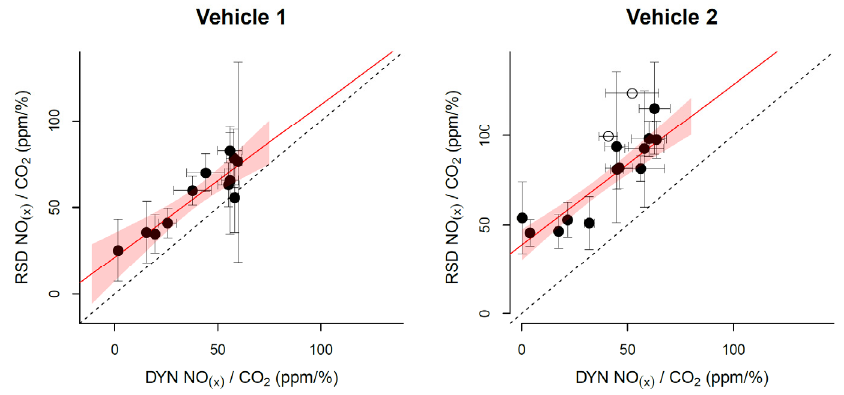
Figure 12. RSD and DYN mean hot running emission ratios, including 95% confidence interval.